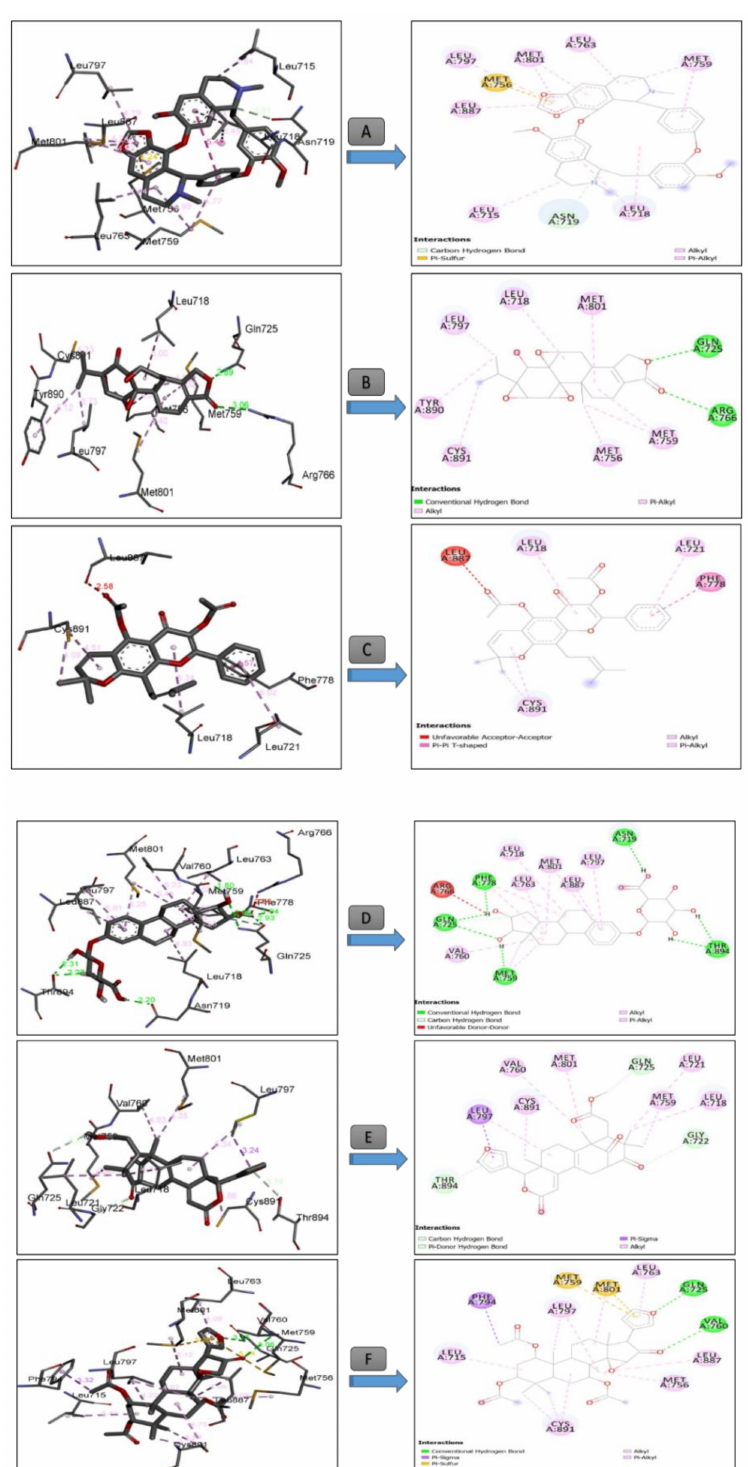
Figure 5. Three-dimensional ( right ) and two-dimensional ( left ) closest interactions between active site residues of the human progesterone receptor and some molecules belonging to di ff erent class compounds with the best score result. Legend: ( A ): Compound 8 (Cepharantine, Class: Alkaloid), ( B ): Compound 20 (Triptonide, Class: Diterpene triepoxide), ( C ): Compound 10 (Sericetin diacetate, Class: Flavonol), ( D ): Compound 24 (16alpha,17beta-Estriol 3-(beta-D-glucuronide, Class: Steroidal glycosides), ( E ): Compound 14 (Carapin-8 (9)-Ene, Class: Limnoid), ( F ): Compound 28 (Khayanthone, Class: